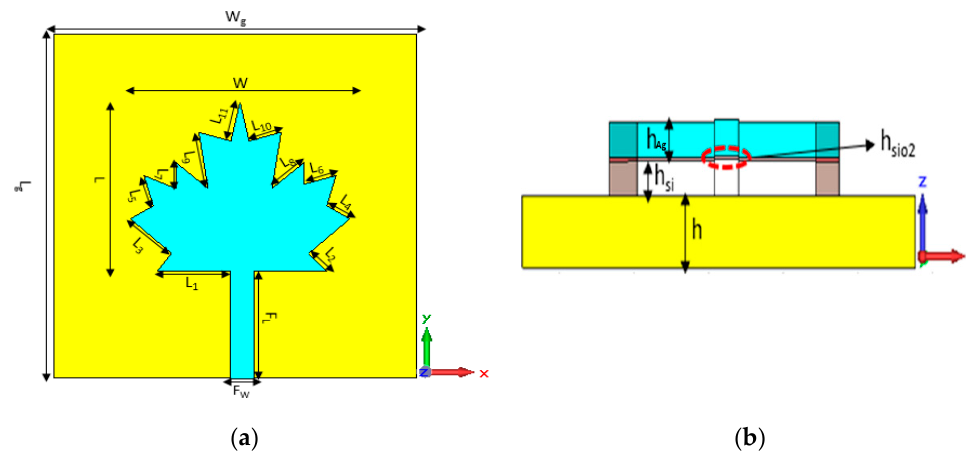
Figure 2. ( a ) Front view; ( b ) side view. Table 1. Geometric parameters of the proposed design.